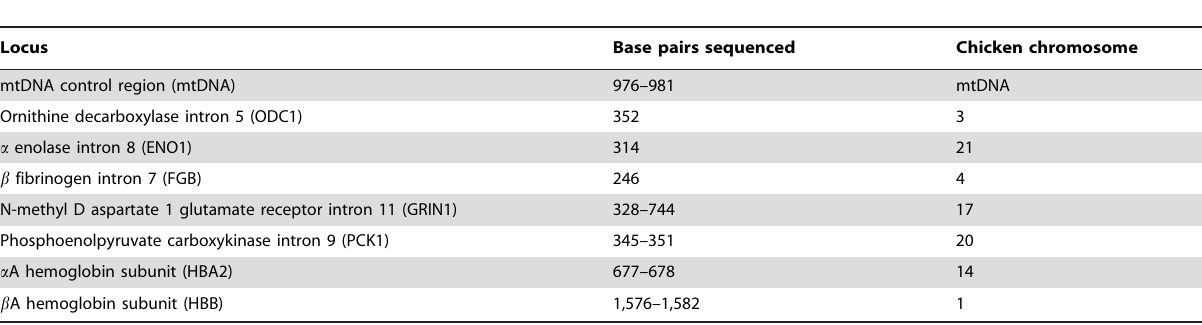
Table 1. Genes sequenced and their chromosomal positions in the chicken genome.